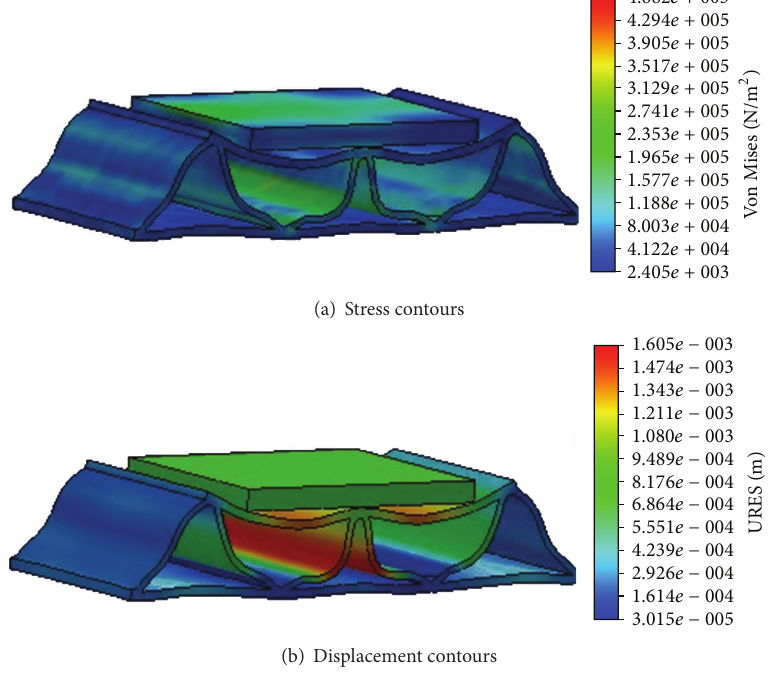
Figure 14: The stress and displacement contours of model with flute height 𝐻 of 5 mm in drop test.